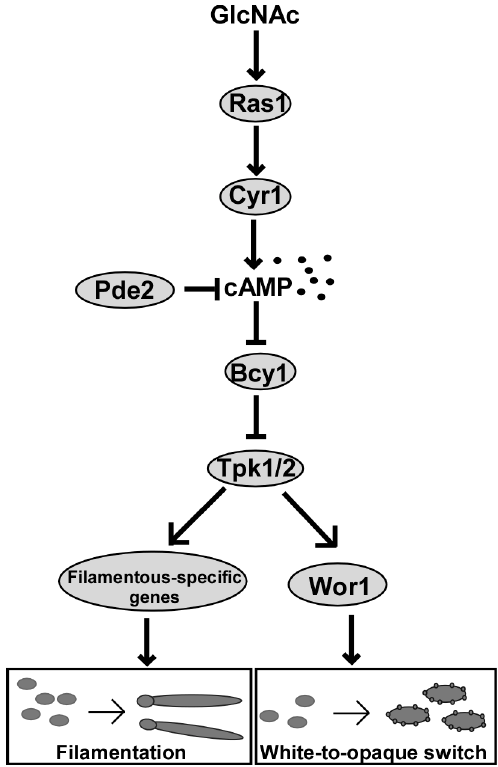
Figure 2. The Ras1-cAMP/PKA signaling pathway regulates GlcNAc-induced filamentation and white–opaque switching in C. albicans. GlcNAc may directly activate the small GTPase Ras1. Activated Ras1 stimulates the adenylyl cyclase Cyr1 to produce cAMP, while the cyclic nucleotide phosphodiesterase Pde2 degrades cAMP. In the absence of GlcNAc, the PKA regulatory subunit Bcy1 binds to the catalytic subunits Tpk1 and Tpk2. In the presence of GlcNAc, cAMP binds to Bcy1 and leads to the release and activation of the catalytic subunits that subsequently phosphorylates filamentation-specific or opaque-specific regulators.